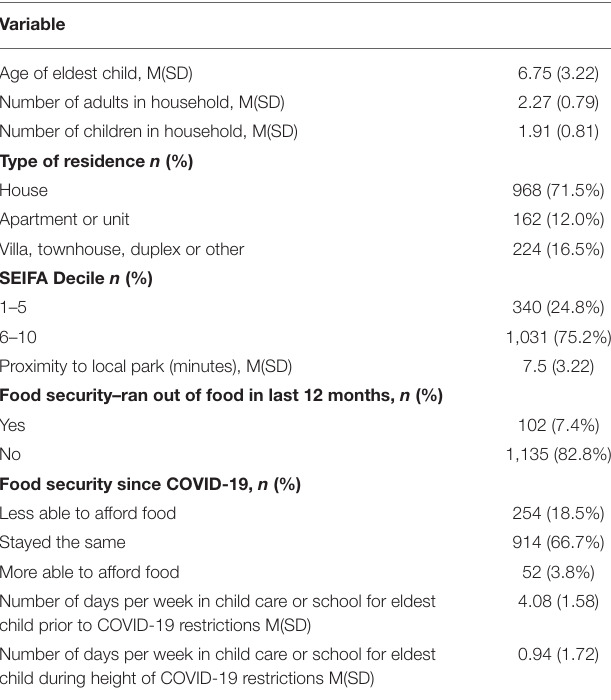
TABLE 2 | Demographics of participants ( n =